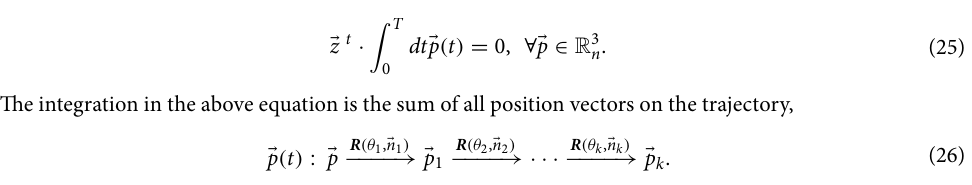
Figure 1. Schematic picture of the trajectory of represents the trajectory of the i -th operation from integration of all position vectors along this